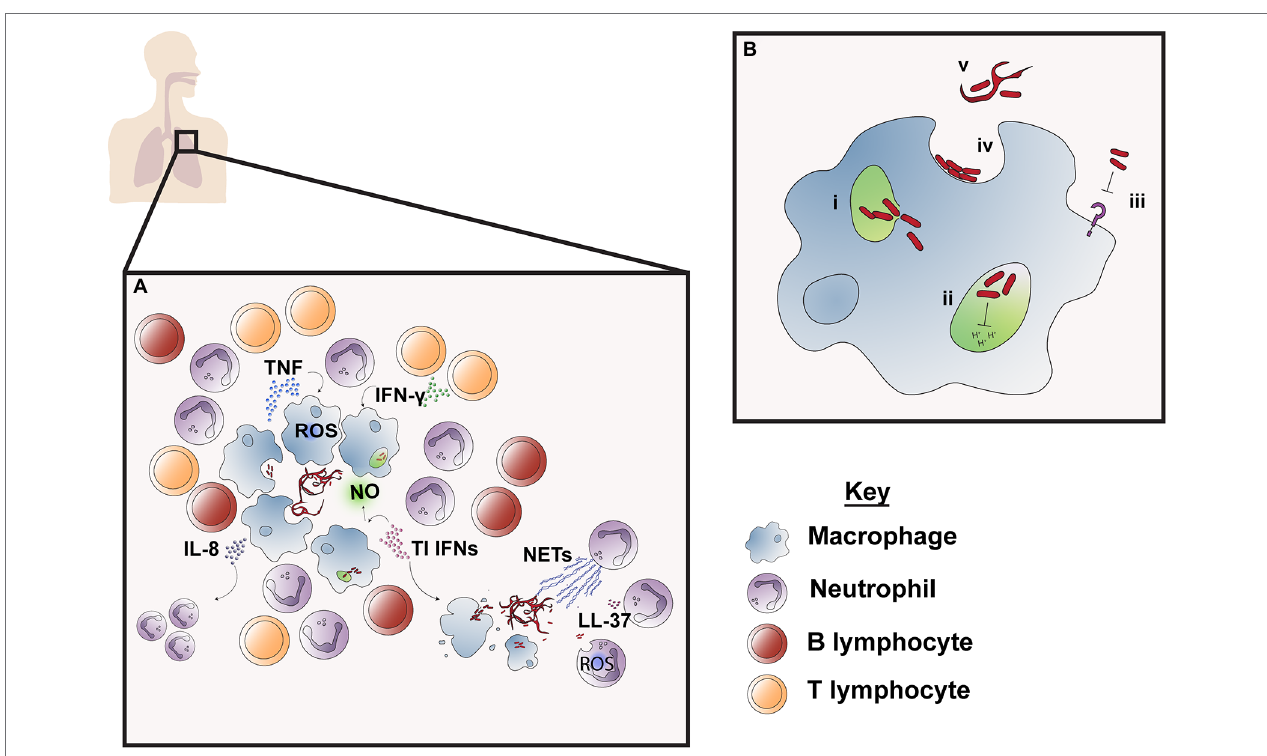
FIGURE 2 | Immune responses to M. abscessus infection . M. abscessus infection is followed by an influx of neutrophils and macrophages surrounded by lymphocytes which work to contain bacteria in the granuloma (A) . Cytokines TNF and IFN- γ produced by macrophages and CD4 + T cells are required for granuloma formation and induce macrophage effector function, such as phagosome acidification and reactive oxygen species (ROS) production, while type I IFN production promotes nitric oxide (NO) production. IL-8 attracts neutrophils which are responsible for phagocytosis, NET production and secretion of antimicrobial peptide LL- 37. However, release of M. abscessus into the extracellular space as a result of cell death leads to the formation of serpentine cords, which are resistant to innate immune defenses and leads to unchecked bacterial replication. M. abscessus also possesses numerous mechanisms of immune evasion to resist macrophage effector functions (B) ; these include bacterial escape from the phagosome to the cytosol through interference with the phagosomal membrane (i); prolonged survival within the phagosome by blocking phagosomal acidification and thereby preventing M. abscessus degradation (ii) and inhibition of macrophage TLR signaling which limits downstream immune cell activation and recruitment (iii). M. abscessus also persists in the extracellular environment by avoiding phagocytosis, which is enabled through adherence to macrophage phagocytic cups on the cell surface (iv) and by forming serpentine cords which are too large to be engulfed by macrophages